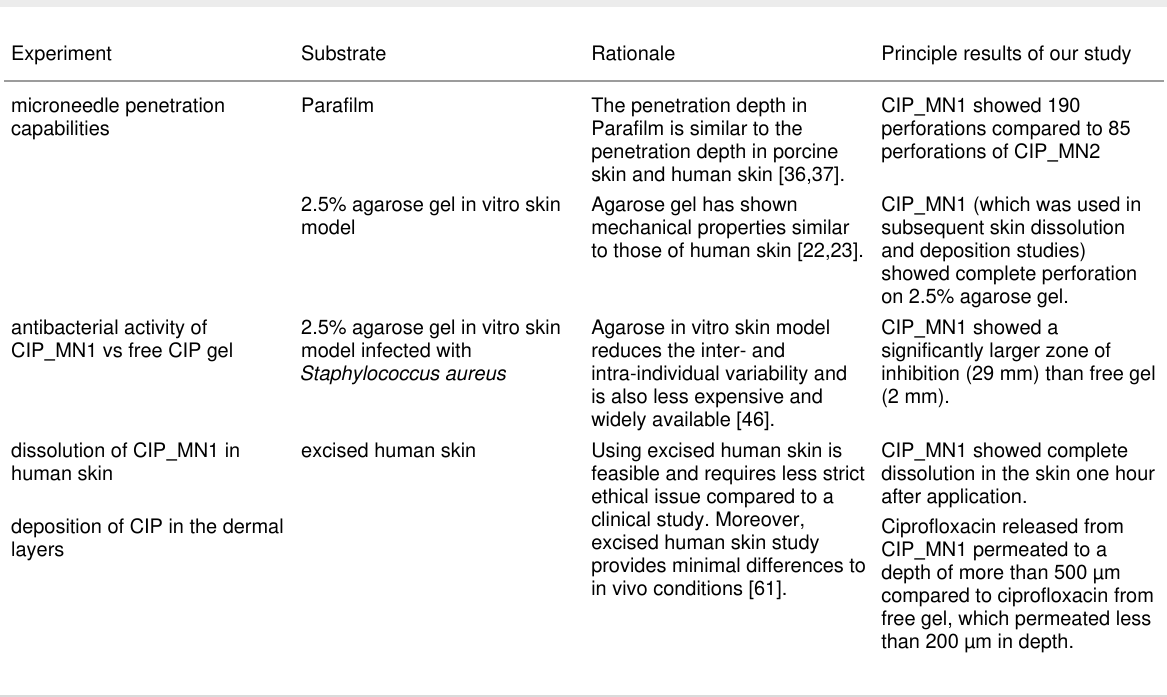
Table 2: CIP_MN1 and CIP_MN2 penetration capabilities with the rationale of the experiment and the principal outcomes.